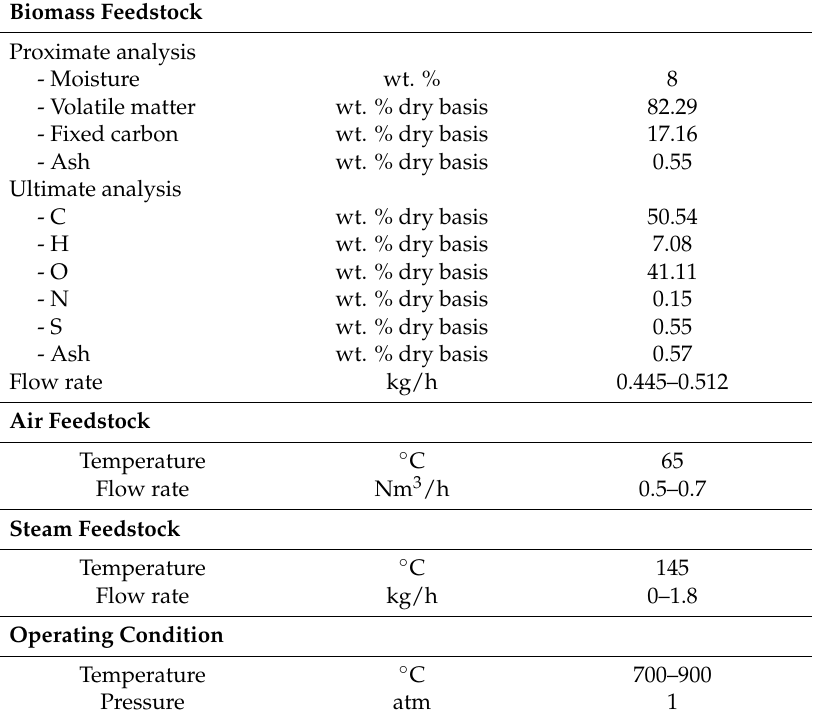
Table 2. Parameter inputs in simulation